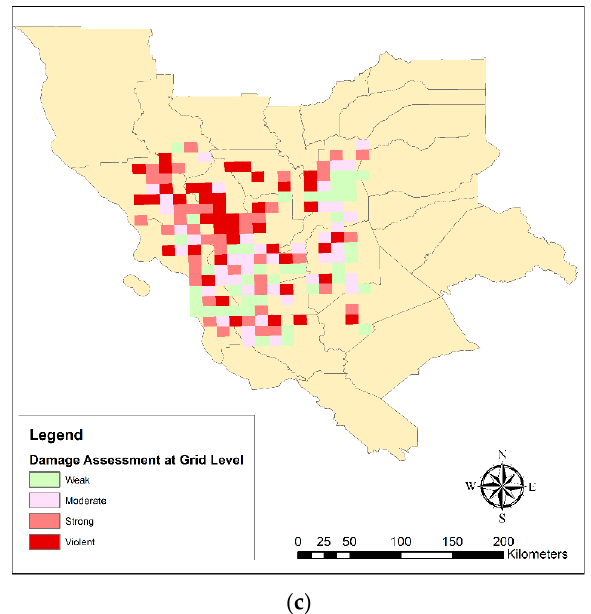
Figure 12. The estimated damage map from ( a ) Naive Bayes, ( b ) SVM, and ( c ) deep learning algorithms at the 10 × 10 km grids scale.